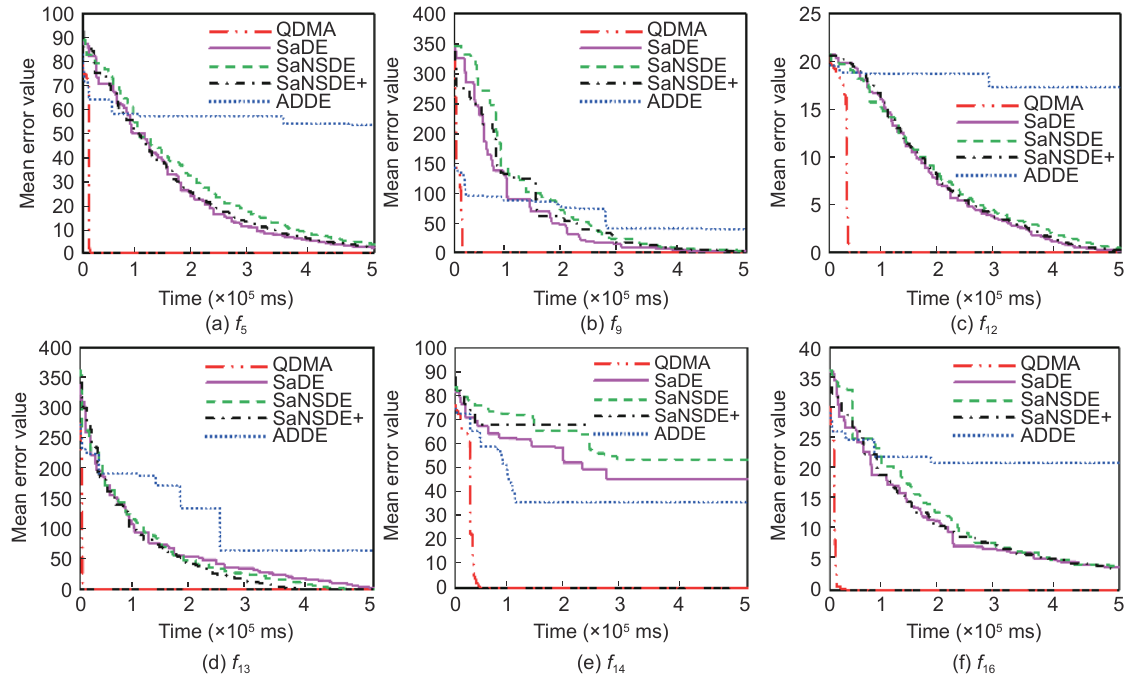
Fig. 6 Convergence graphs of QDMA and DE variants on 50 D problems.